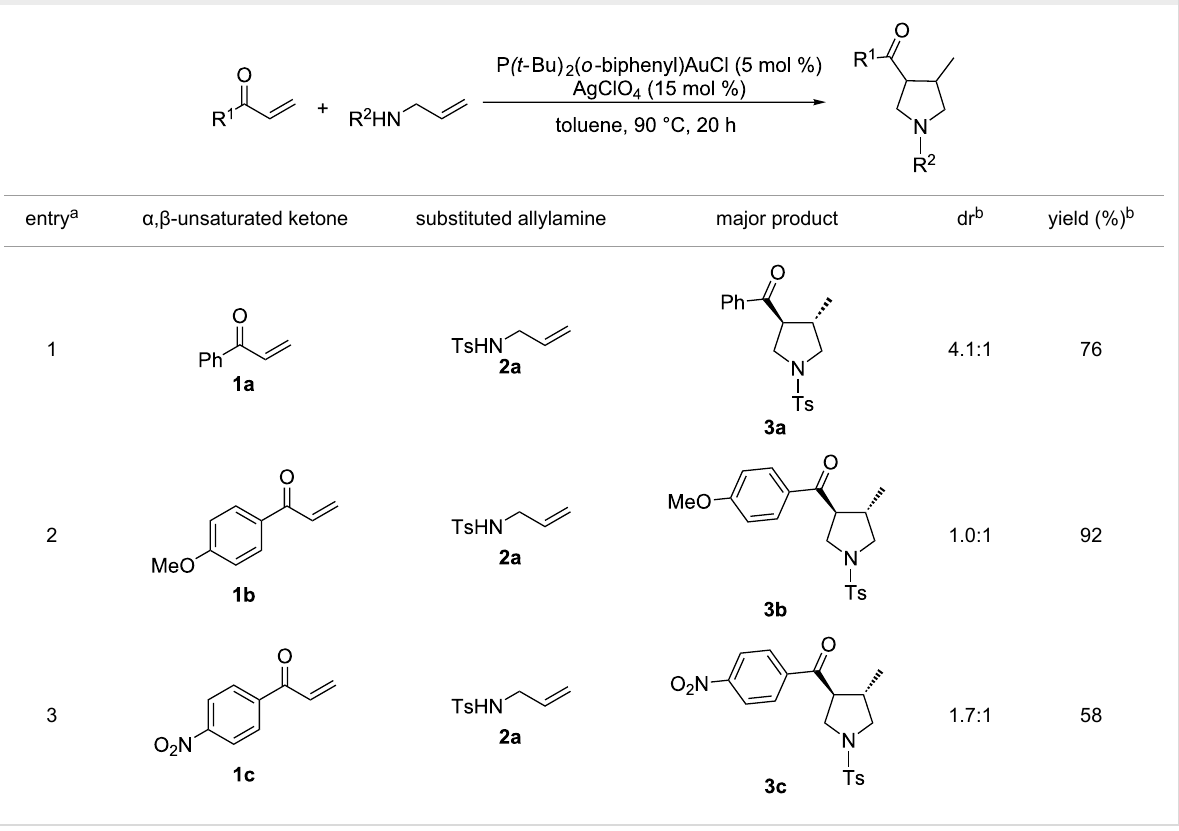
Table 3: Cascade synthesis of pyrrolidine catalyzed by a dual-metal catalytic system comprising of gold(I) and silver(I) catalysts.